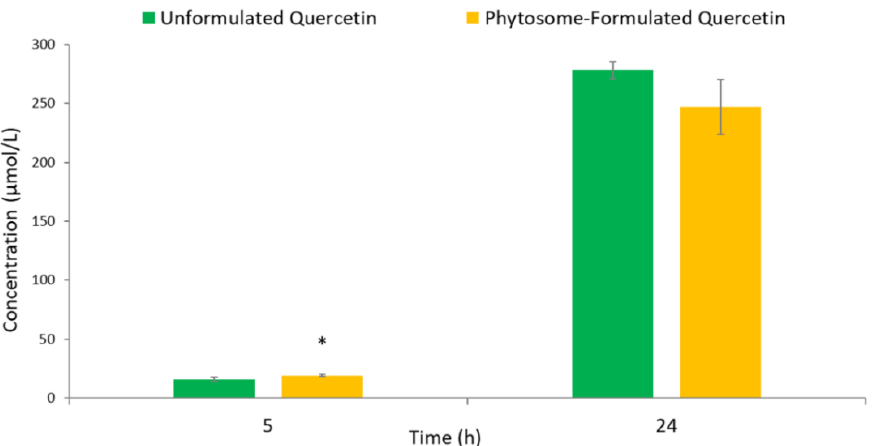
Figure 3. Concentrations (µmol/L) of total fecal phenolic metabolites after 5 h and 24 h of in vitro fermentation of unformulated and phytosome-formulated products. Data are expressed as means ± SD ( n = 3). Note: * p < 0.05, indicate significant differences between products for the same incubation period.